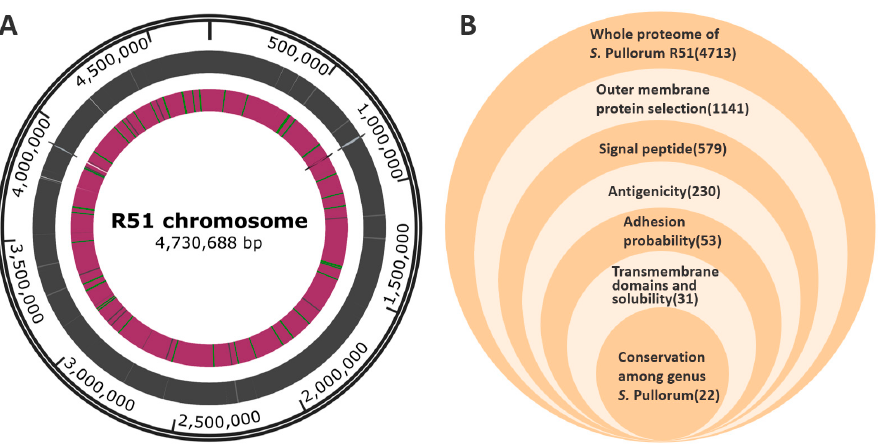
Figure 2. ( A ) Complete genome sequence of S. Pullorum R51; ( B ) Overview of the reverse vaccinology steps used in this study to predict potential vaccine candidates against the S . Pullorum R51 strain.